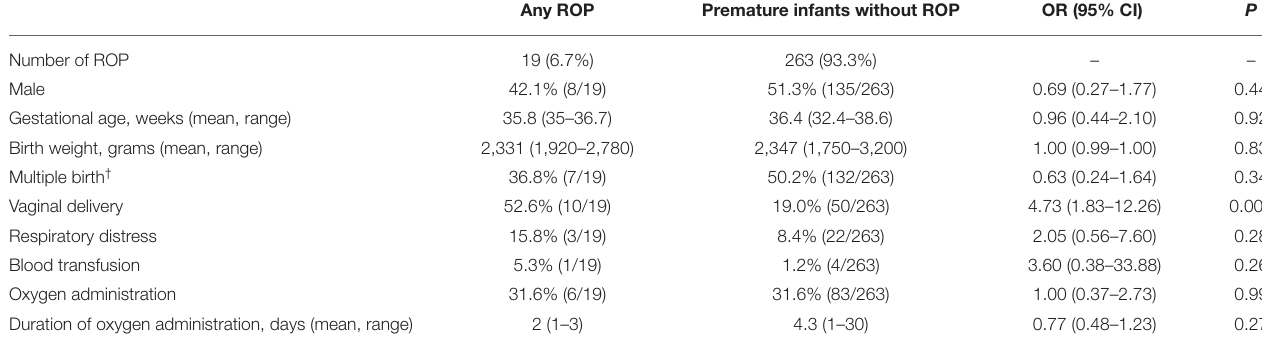
TABLE 3 | Comparisons of any ROP and those without ROP among premature infants with both late gestational age and large birth